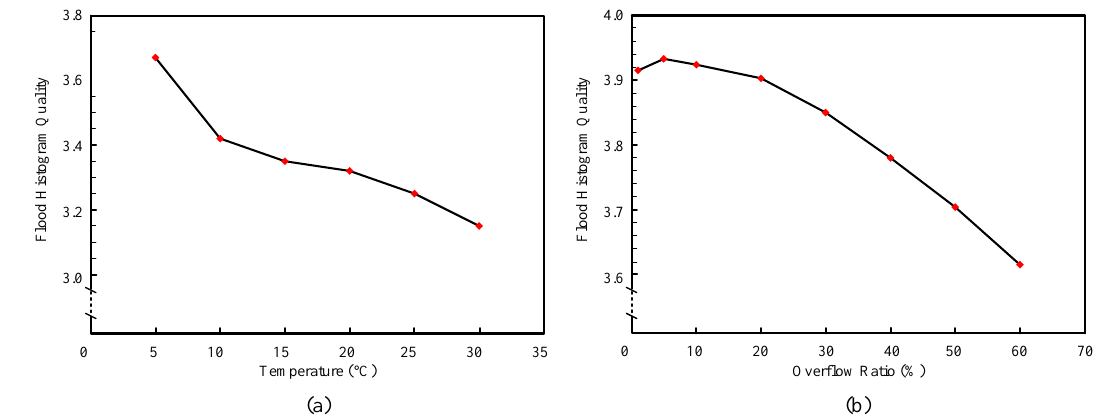
Figure 15. The flood histogram quality parameter values of different temperatures ( a ) and different ADC overflow ratios ( b